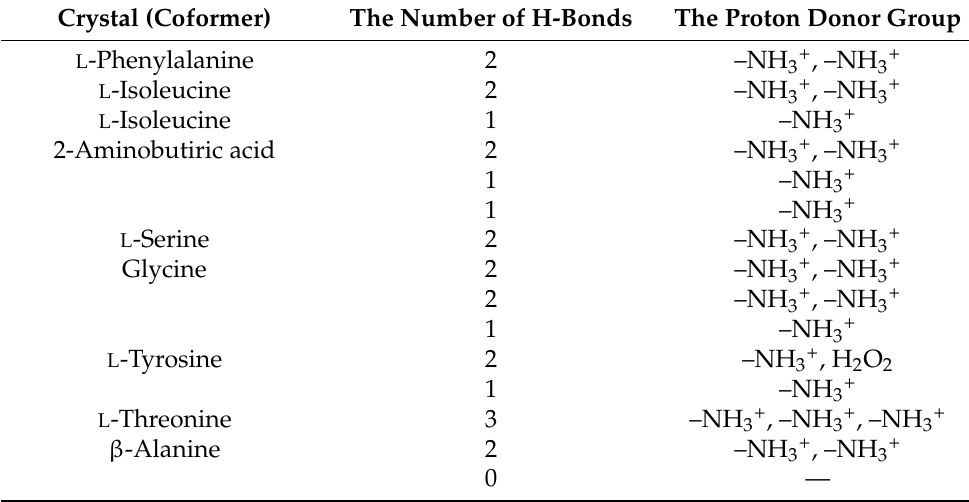
Table 2. H-bonds of H 2 O 2 molecules as proton acceptors in crystalline peroxosolvates of amino acids and non-proteinogenic amino acids [95]: the number of H-bonds formed by one H 2 O 2 molecule and nature of the proton donor